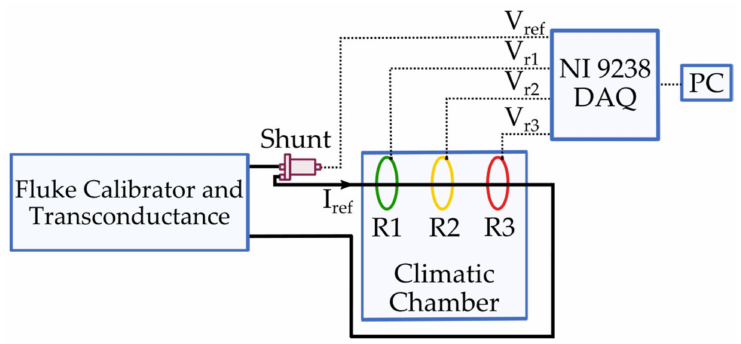
Figure 1. Measurement setup developed for the type